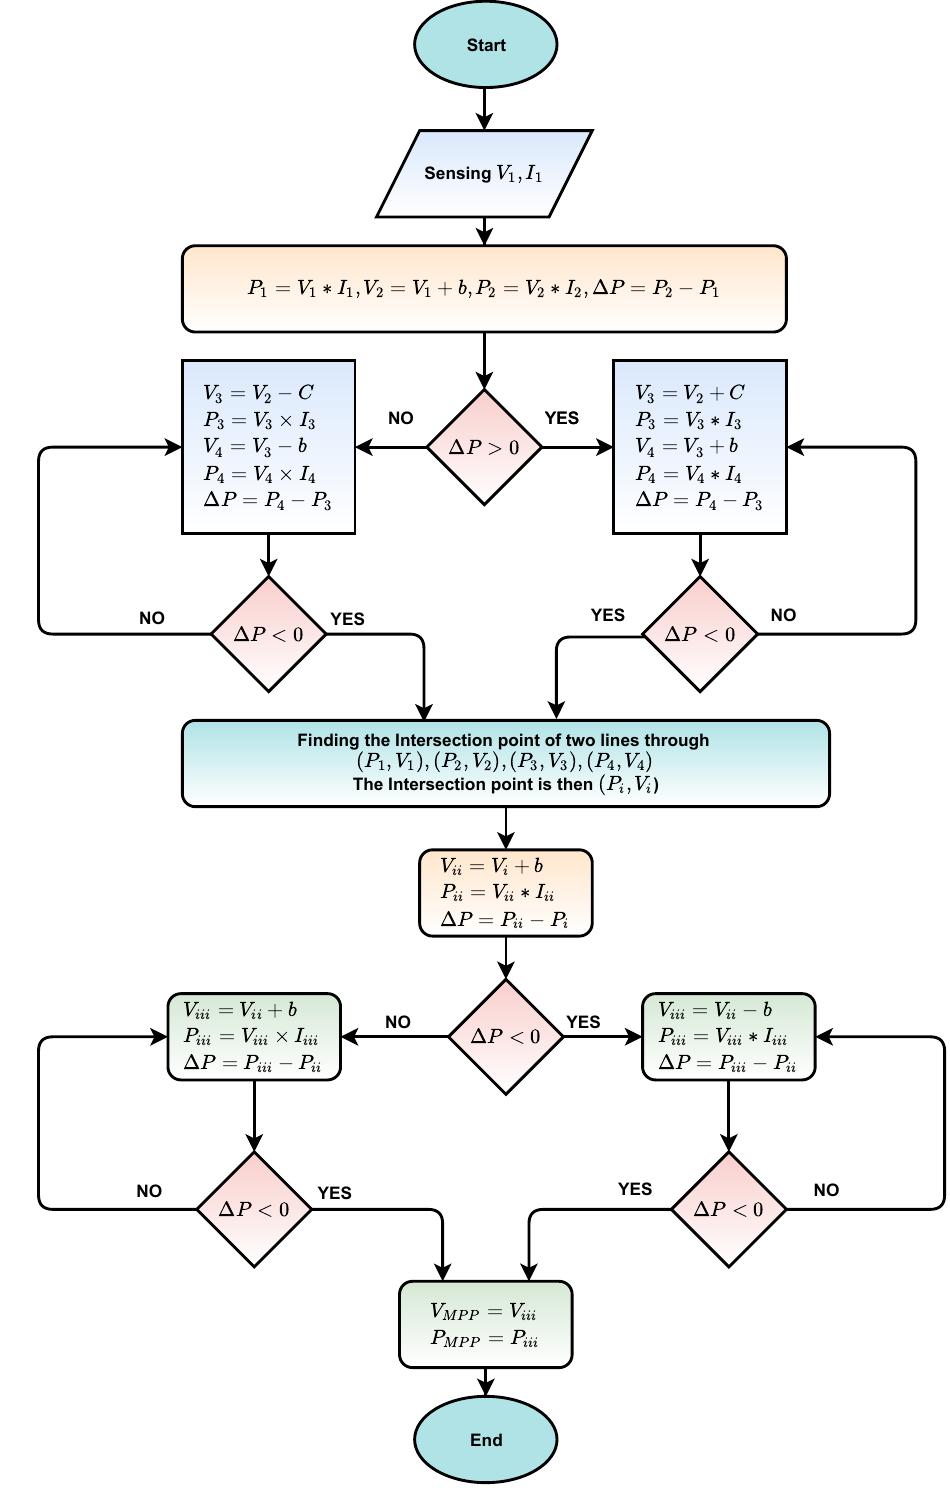
Figure 2. Flowchart of the Proposed